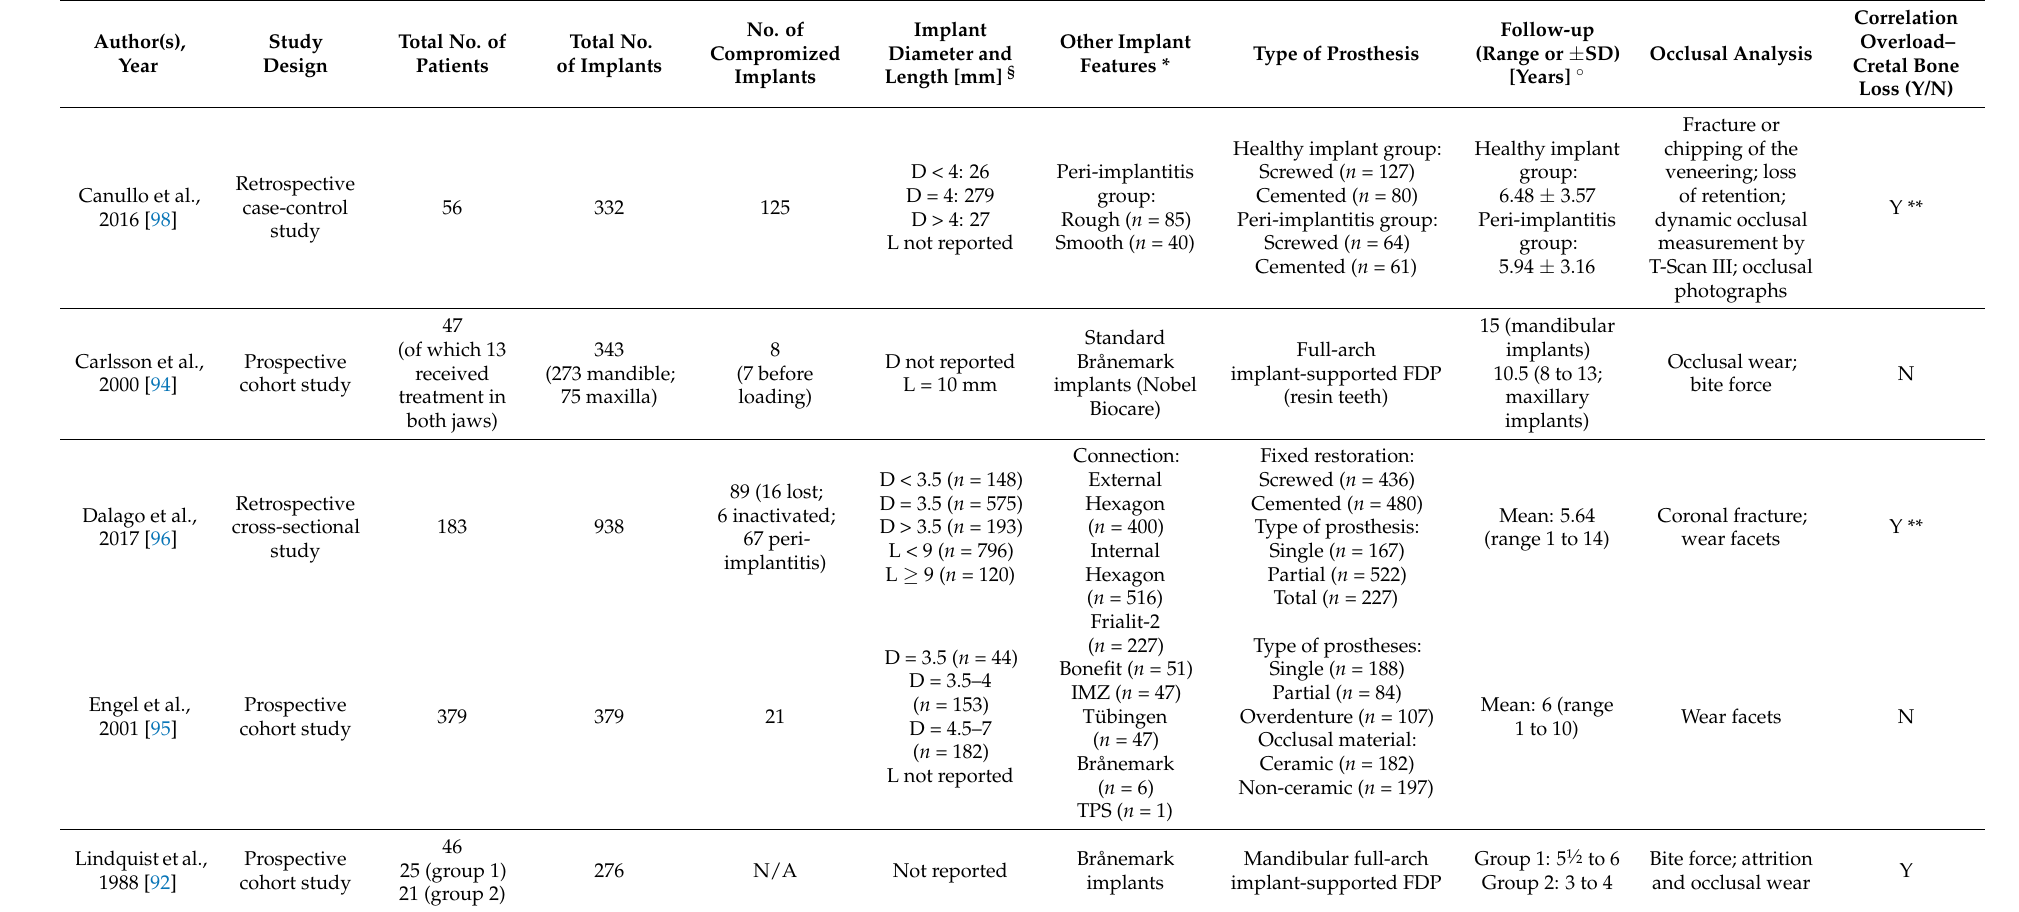
Table 1. Main features of the included